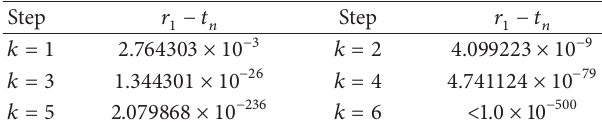
Table 3: Error results for Corollary 7 (‖𝑥 𝑛 − 𝑥 ∗ ‖ ≤ 𝑟 1 − 𝑡 𝑛 )